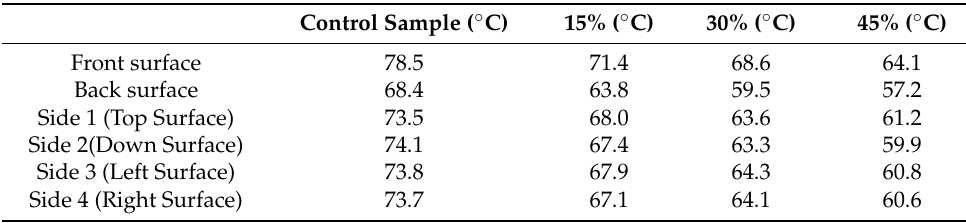
Table 2. Steady-state temperatures at different surfaces for all the samples.